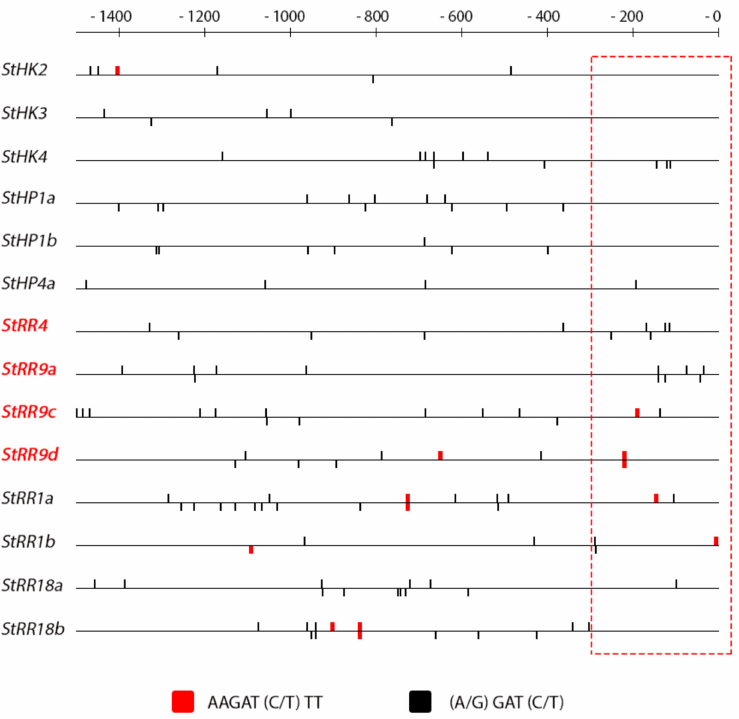
Figure 8. Pattern of CK-specific cis -elements (CREs) in promoters of CK signaling potato genes. Names of classical CK-sensitive RR-A genes are marked red. The scale on the top shows distance in bp upstream the transcription start. Presumable promoter zone rendering gene sensitive to CK is outlined by dotted red